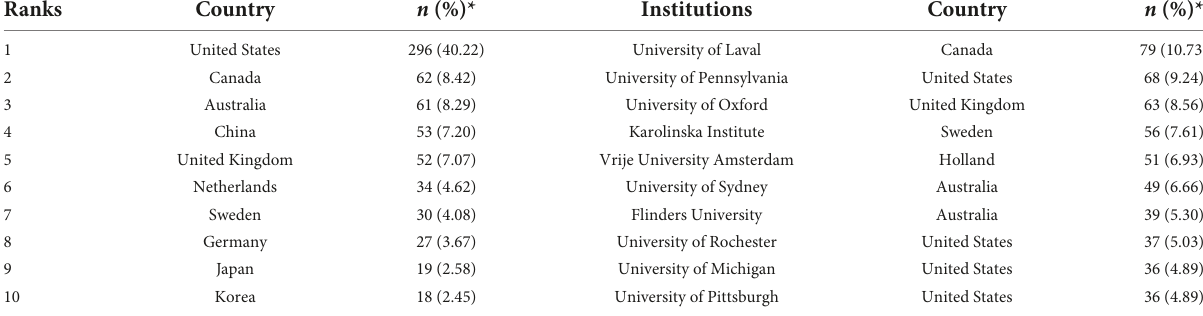
TABLE 3 Top 10 countries and institutions contributing papers on